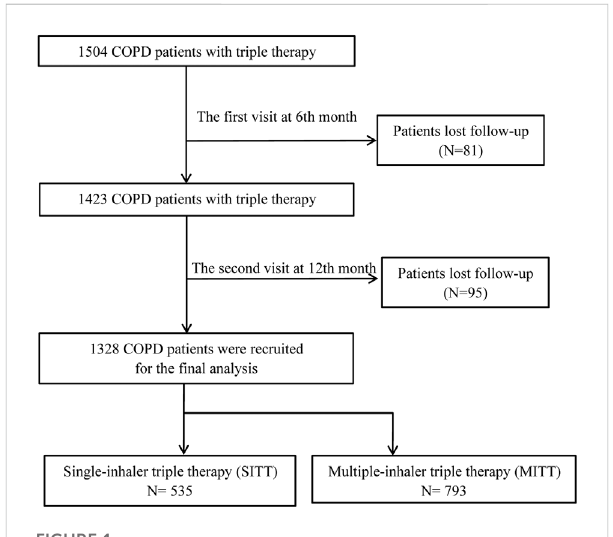
FIGURE 1 Flowdiagramofthestudy ’ sinclusion.COPD,chronicobstructive pulmonary disease, MITT, multiple triple-inhaler therapy; SITT, single triple-inhaler